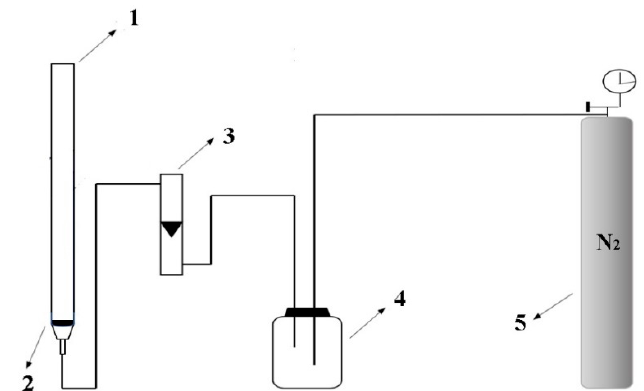
Figure 1. The flotation unit consisted of 1. flotation column; 2. G4 glass core; 3. flowrator; 4. gas buffer device reformed by float type oxygen inhaler; 5. high purity nitrogen cylinder.